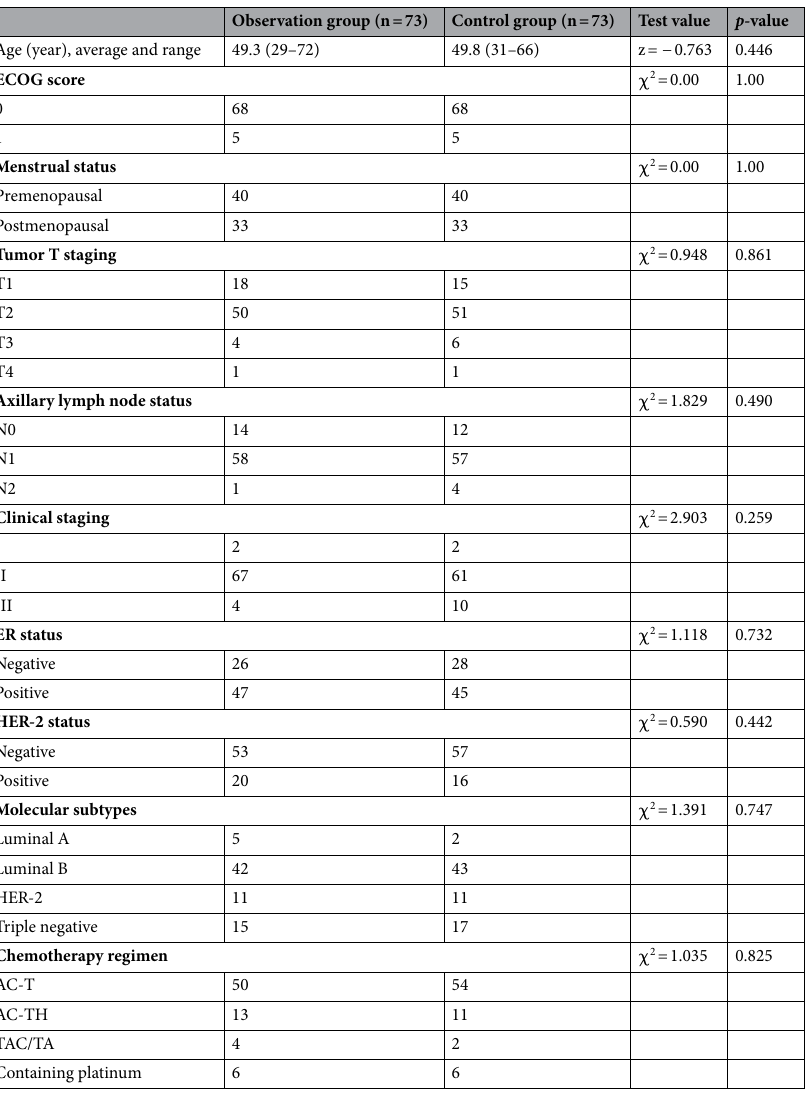
Table 1. Comparison of the characteristics of the patients between observation group and control group. ECOG score Eastern Cooperative Oncology Group (ECOG) physical score, ER estrogen receptor, HER-2